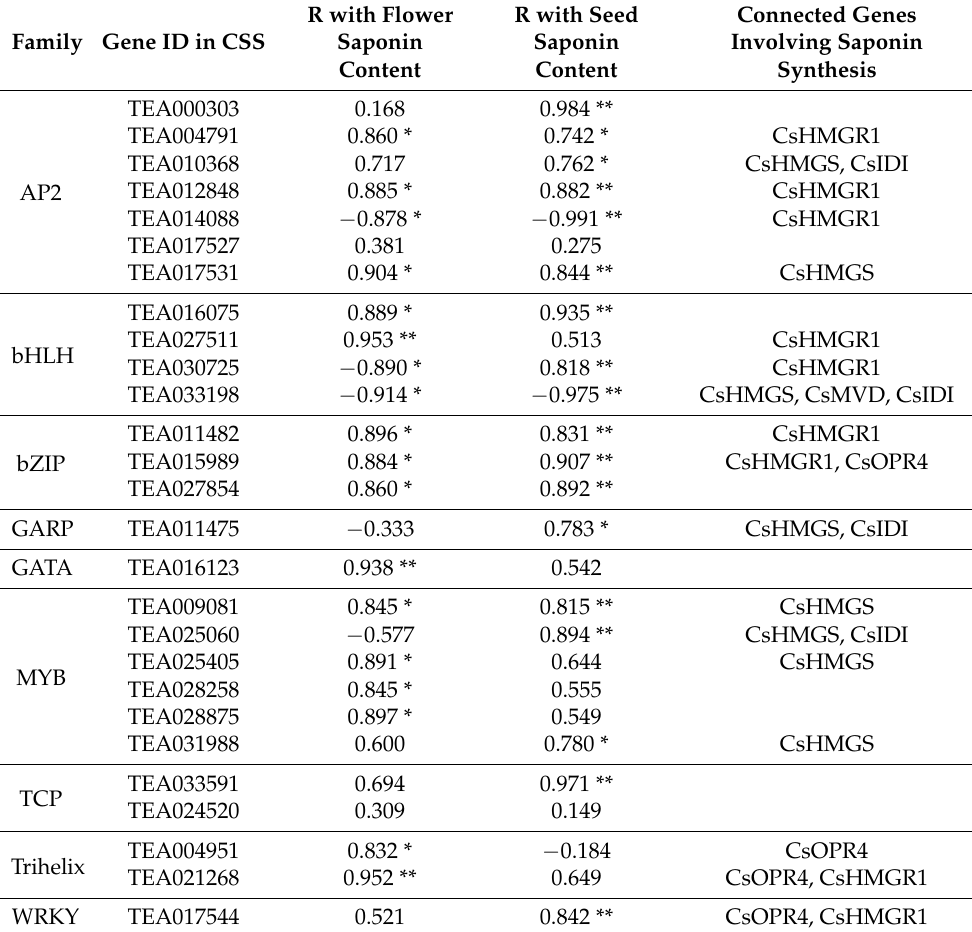
Table 1. Transcription factors in red and black modules and their correlation with saponin content and synthesis-related genes. Family Gene ID in CSS